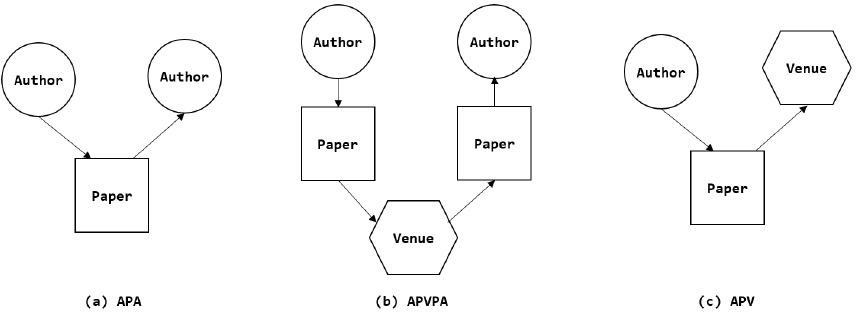
Figure 14. Heterogeneous Information Network Meta-path for Bibliographic Data ( a ) APA ( b ) APVPA ( c )